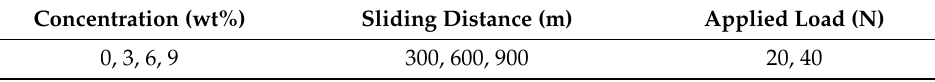
Table 1. General full factorial experimental.